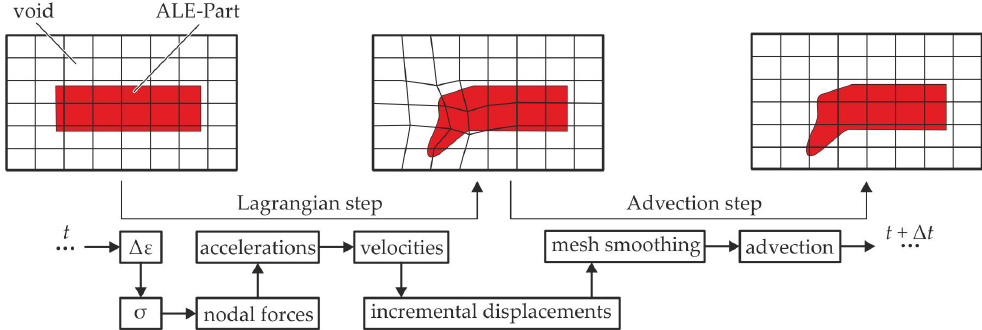
Figure 5. Mesh motion and calculation schedule of the explicit ALE approach for one time step ∆ t